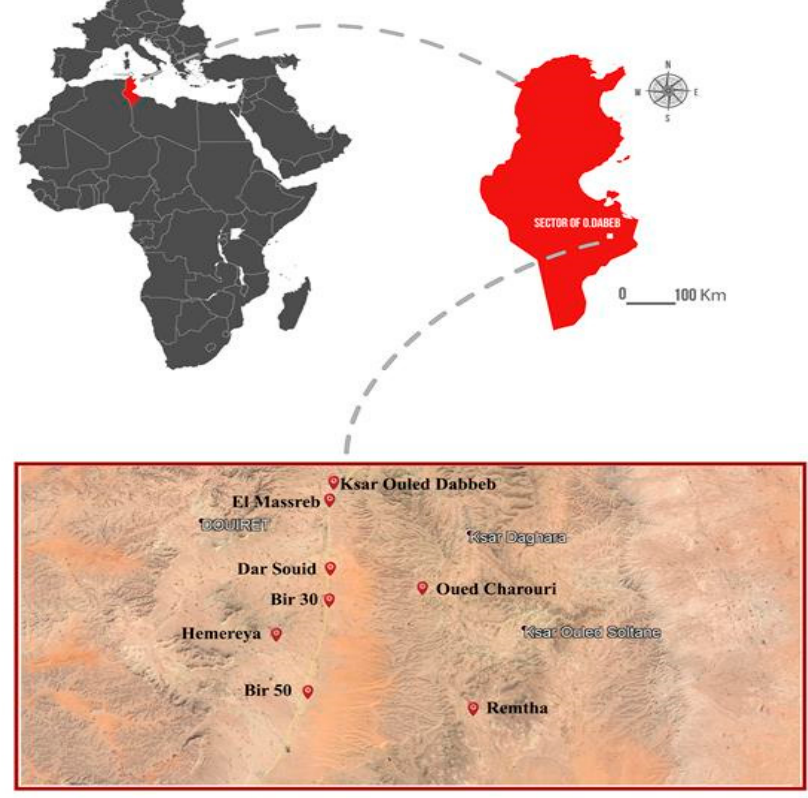
Figure 8. Geographical location of sector Ouled Dabbeb, the study (WGS 84/UTM zone 28N).